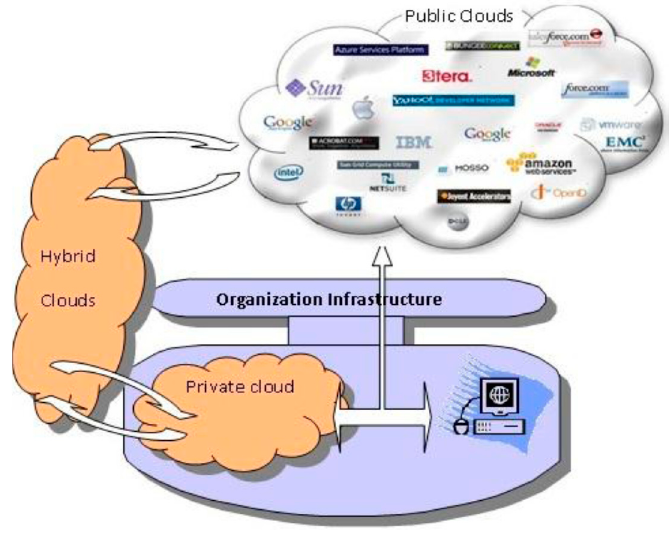
Figure 2. Cloud computing model.